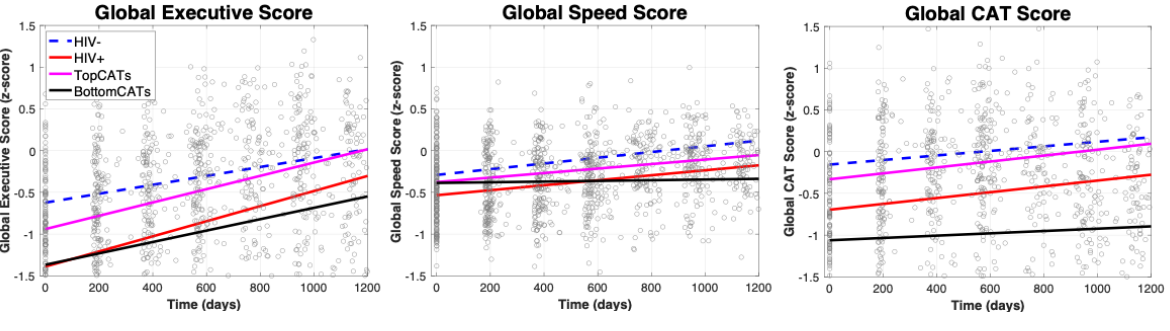
Figure 3. Trajectory of derived global scores over time. The color scheme of lines for each group is the same as that in Figure 1. CAT: central auditory test; TopCATs: HIV-positive individuals in the top 20% of central auditory test scores; BottomCATs: HIV-positive individuals in the bottom 20% of central auditory test